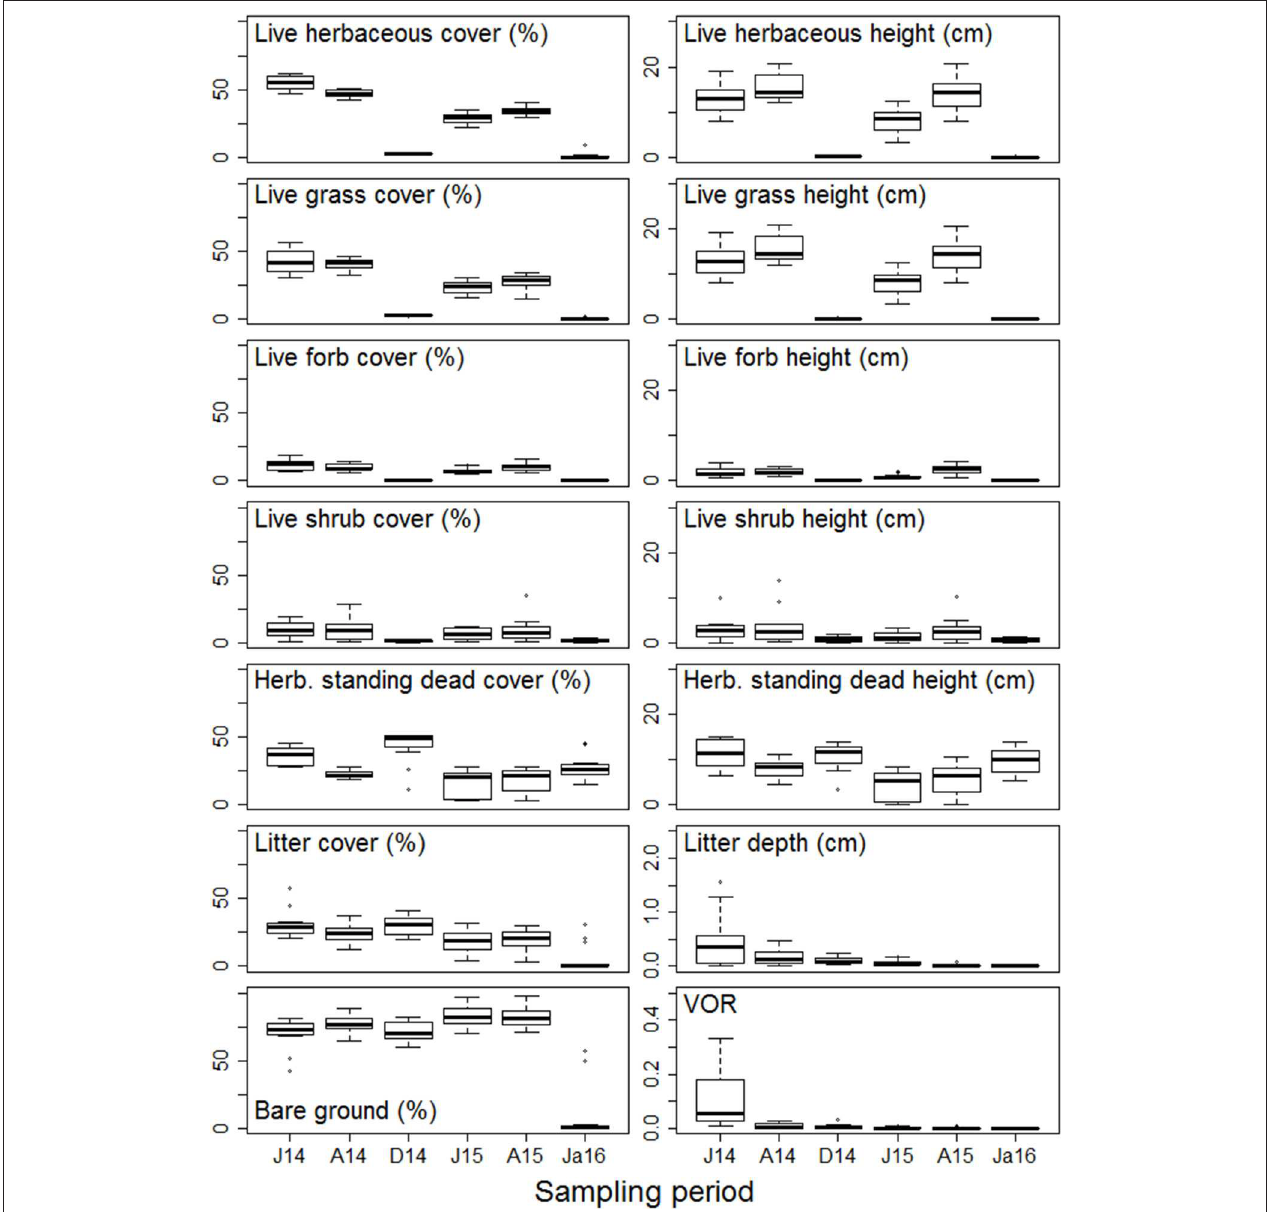
FIGURE 5 | Mean and standard error of vegetation structural metrics [estimates of percentage foliar cover, litter cover, and bare ground; vegetation height and litter depth; and visual obstruction reading (VOR)] collected over six sampling periods in a Nebraska Sandhills grassland managed with patch burning. Sampling